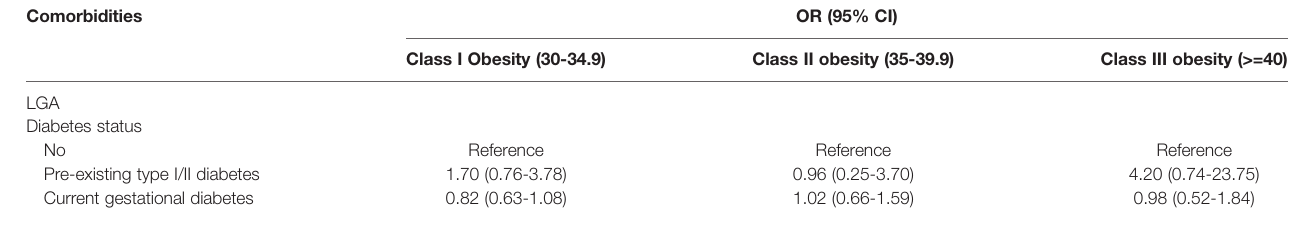
TABLE 4 | Interaction between obesity class and diabetes status for